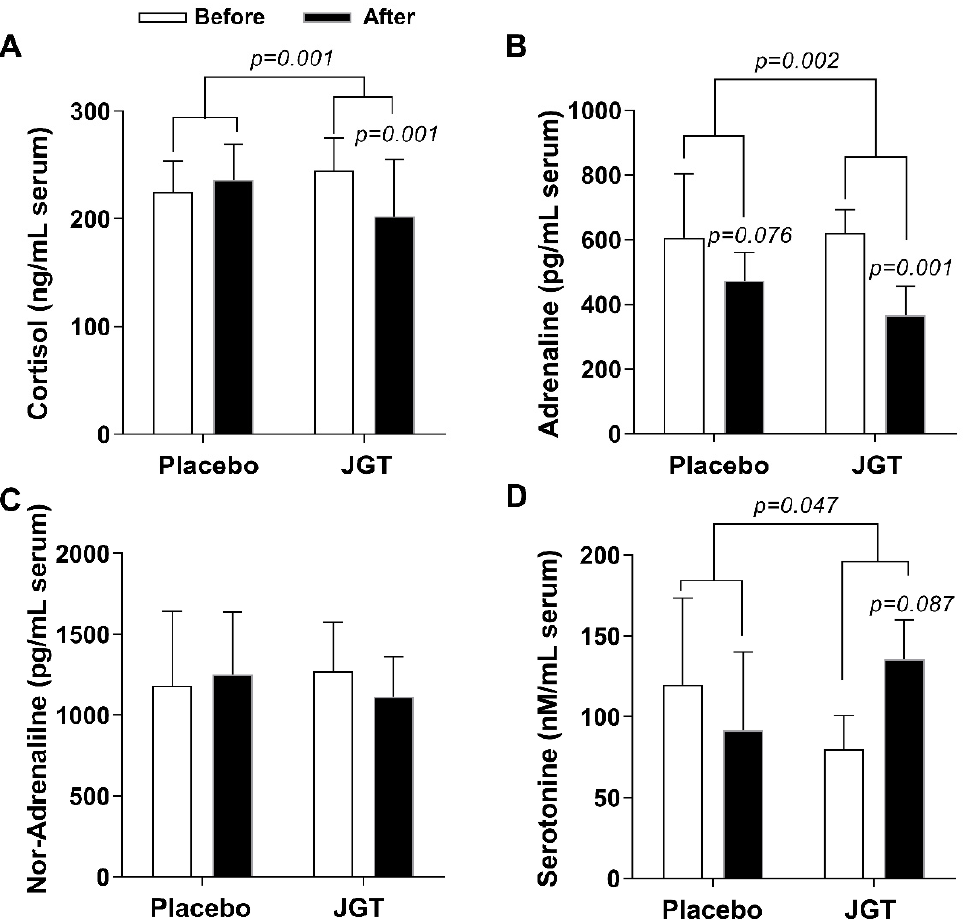
Figure 2. Effects of JGT on stress-related hormone release in serum levels. Serum levels of ( A ) cortisol, ( B ) adrenaline, ( C ) noradrenaline, and ( D ) serotonin were measured after the completion of trials. Data were expressed as mean ± SD. The p -values were calculated by comparing before and after treatment changes within each group and between the two groups.